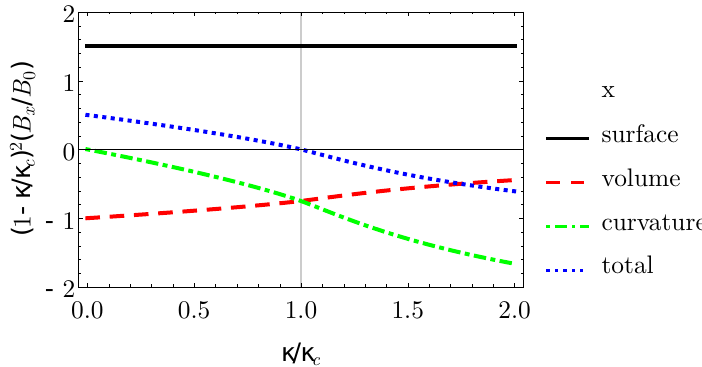
Figure 8. Contributions B x as a function of κ/κ c to the tunneling exponent. The line pat- terns (solid line, dashed line, dash-dotted line, dotted line) respectively represent B surface , B volume , B curvature and B total